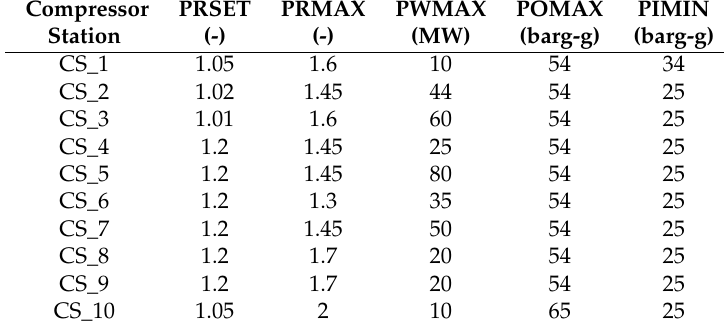
Table 3. Compressor station control (PRSET—Pressure Ratio Set Point) and constraints (PRMAX— Maximum Pressure Ratio, PWMAX—Maximum Available Driver Power, POMAX—Maximum Discharge Pressure, PIMIN—Minimum Suction Pressure).